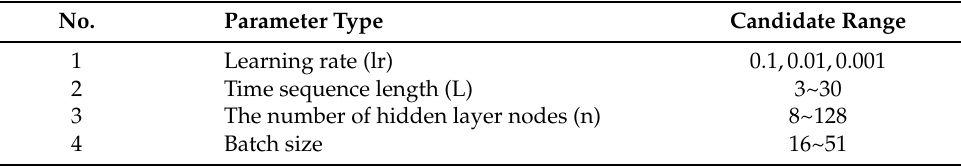
Table 2. The candidates for modeling parameters.